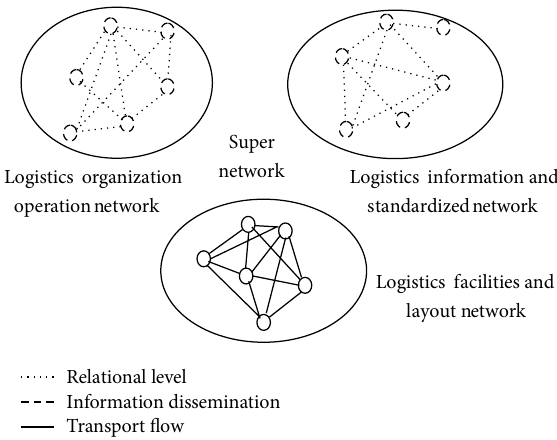
Figure 1: Supernetwork structure model of regional